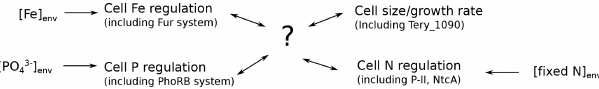
Figure 5. The metaproteomes suggest that there is a currently un- known regulatory link between cellular Fe, P, and N regulation. Fur is the ferric uptake regulator, PhoRB is the phosphate two- component sensory system, Tery_1090 is the putative cell-size reg- ulator, and P-II and NtcA are nitrogen regulatory